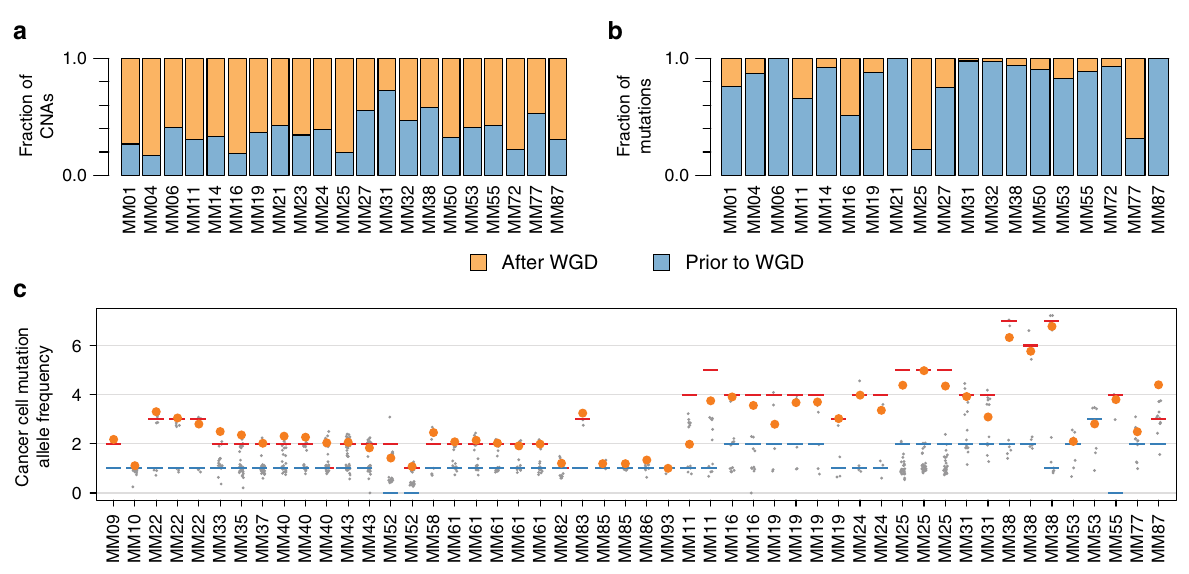
Fig. 5 Timing of genome duplication and gain of mutated BRAF . a , b Estimated fraction of copy number events ( a ) and mutations ( b ) in assessable regions of the genome that occurred prior to and after genome duplication. c The relative allelic frequency (corrected to show allelic status of mutation) for mutations in the genomic segment harboring the BRAF gene in samples with a BRAF mutation. Allelic states are shown as red (major allele) and blue (minor allele) lines; mutations are shown as points, where the BRAF mutation is colored orange and all others are colored